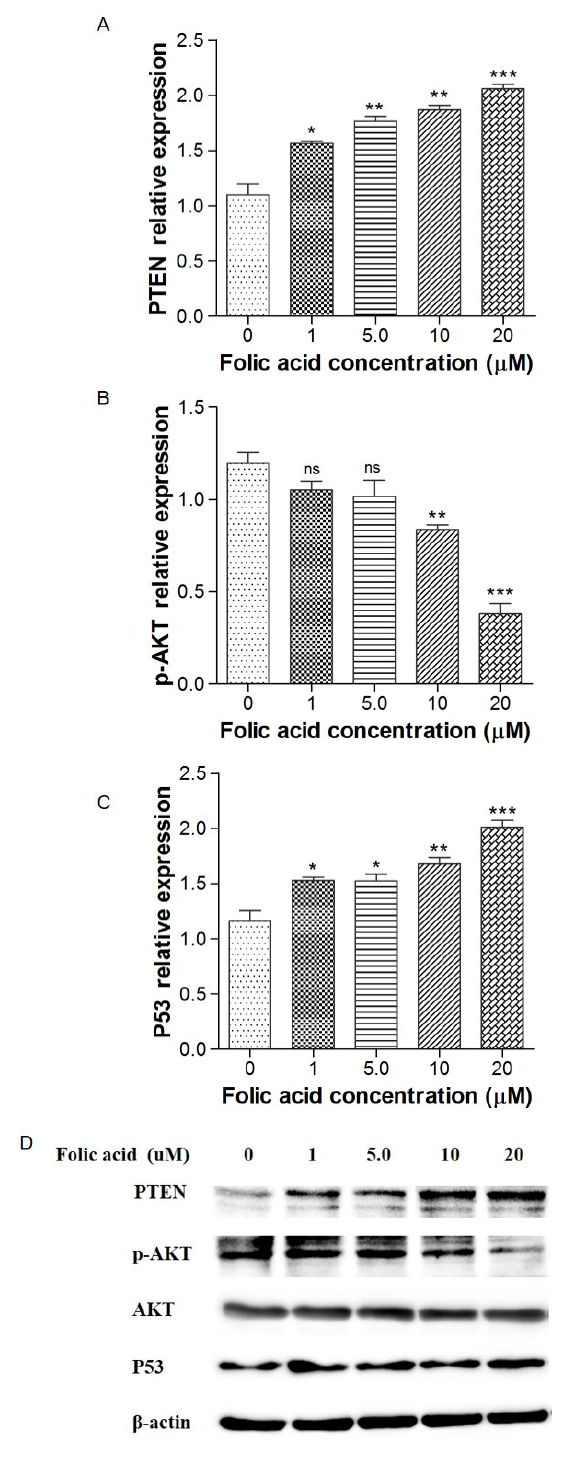
Figure 2: Folic Acid up-regulates the expression level of PTEN and P53, and inhibits the expression level of p-AKT in MDA-MB-231 cells. After treatment with MDA-MB-231 breast cancer cells at different concentrations (0 μM, 2.5 μM, 5 μM, 10 μM, 20 μM) for 24 h, the expression levels of PTEN, p-AKT, AKT and P53 protein were detected by Western blot, and β-Actin was used as internal reference